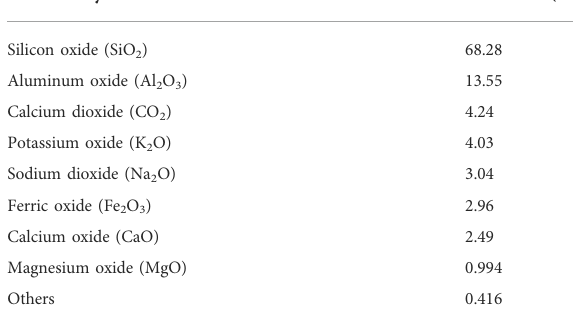
TABLE 1 Chemical composition of the tested rock.